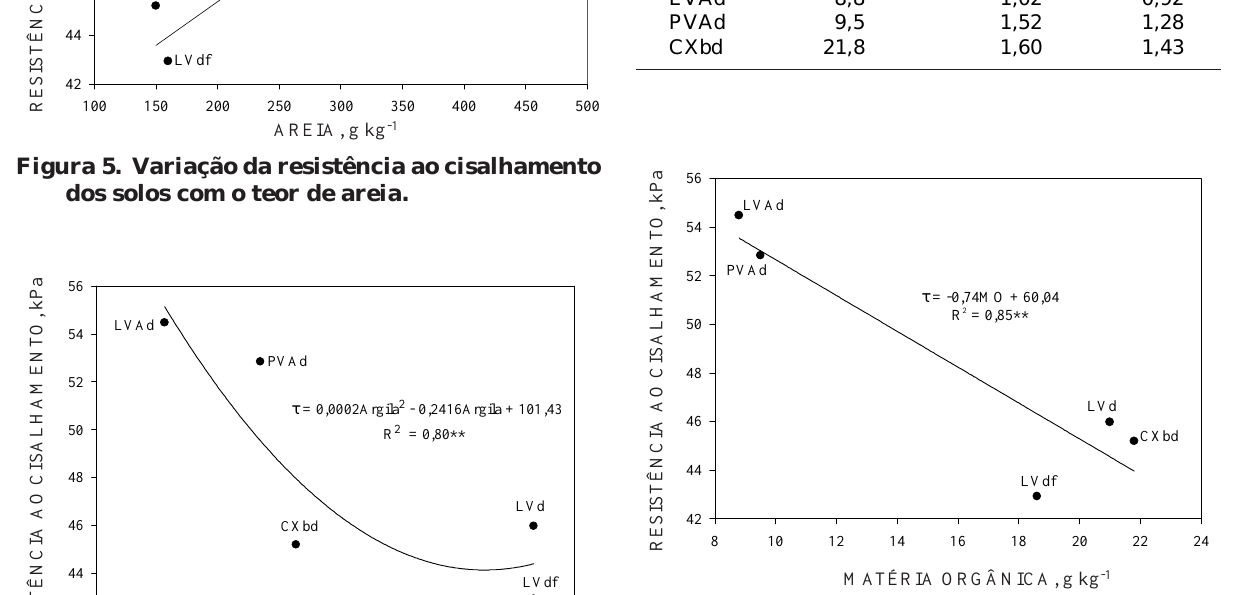
Figura 7. Variação da resistência ao cisalhamento do solo com o teor matéria orgânica.